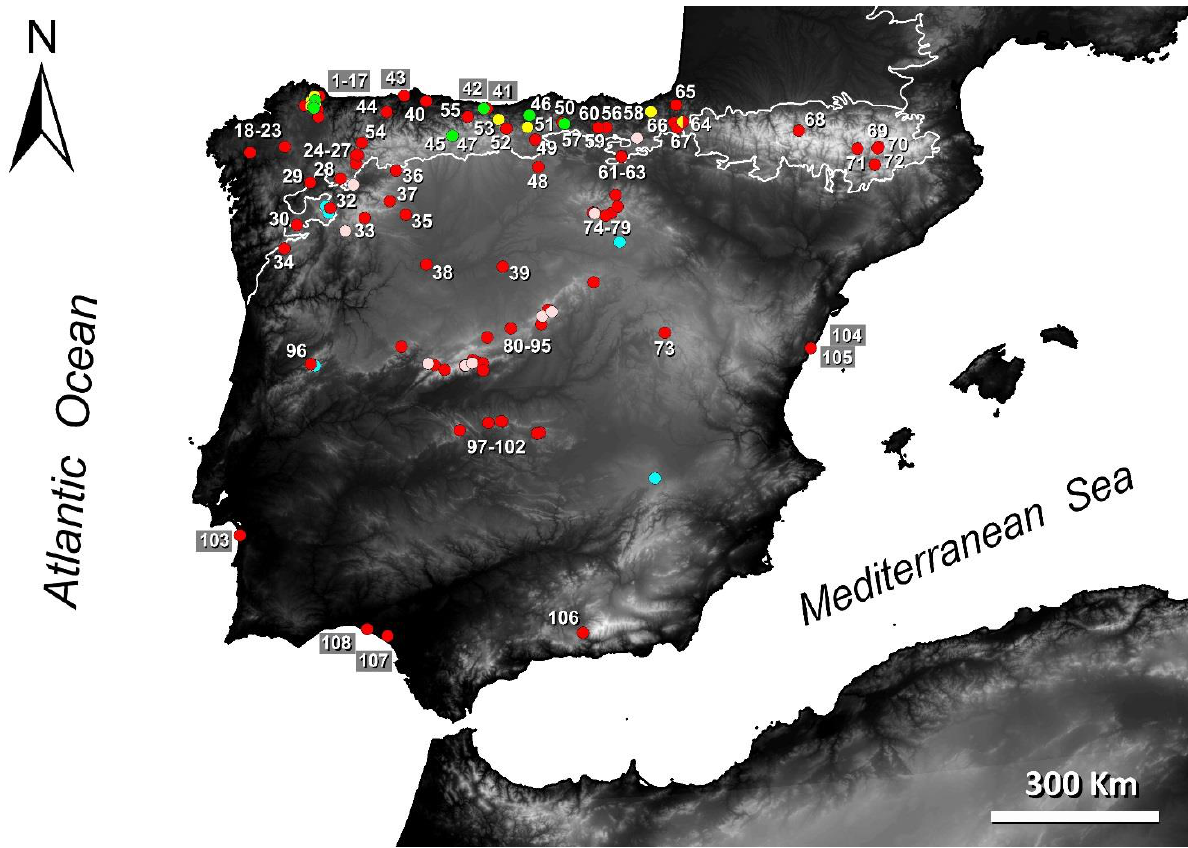
Figure 1. Geographical location of the 108 peatlands analysed. Sequence numbers refer to the Appendix. Red circles: fens; green circles: blanket bogs; yellow circles: raised bogs; blue circles: para-peaty soils; pink circles: peatlands without 14 C data. The white line separates the Eurosiberian, Mediterranean and Alpine